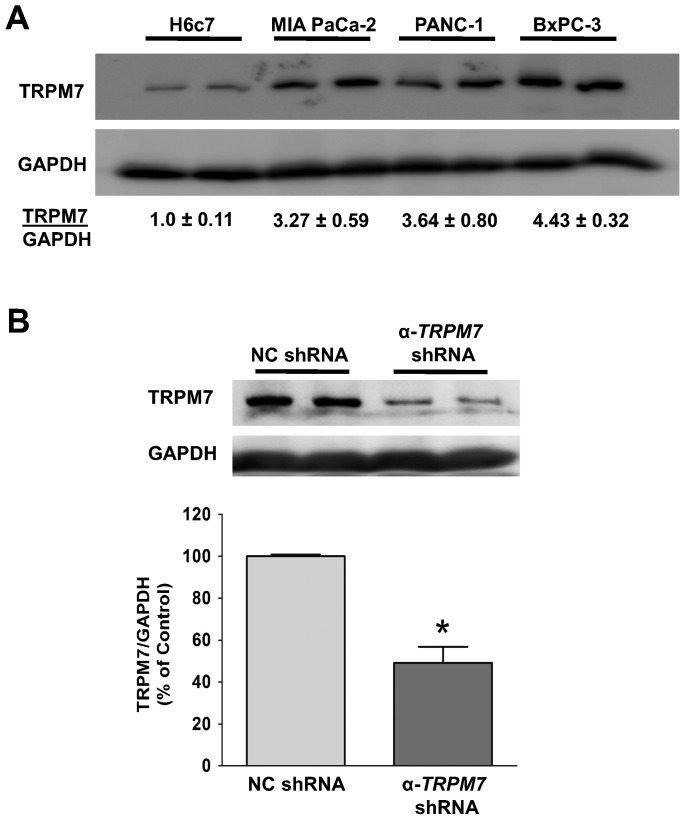
TRPM7 is over-expressed in pancreatic adenocarcinoma cells, and its expression can be down-regulated by shRNA.(A) Cell lysates of each cell line were analyzed for the protein levels of TRPM7 by immunoblotting. The relative amount of TRPM7 and GAPDH protein in each cancer cell line was compared to that in H6c7 as indicated (mean ± standard error). (B) Immunoblotting analysis of TRPM7 protein in BxPC-3 cells transfected with either non-targeting control (NC) shRNA or anti-TRPM7 shRNA. The relative amount of TRPM7 and GAPDH protein in each group of cells is expressed as % of control (NC shRNA). Each column represents the mean ± standard error of three experiments with duplicate samples in each experiment. *indicates statistically significant difference with P<0.05.